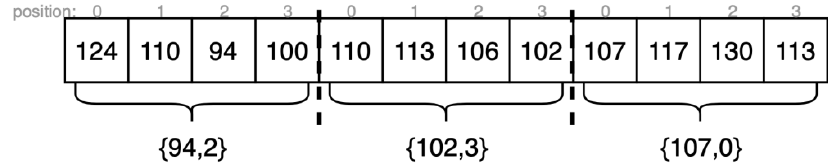
Figure 9. Example of region optimization.